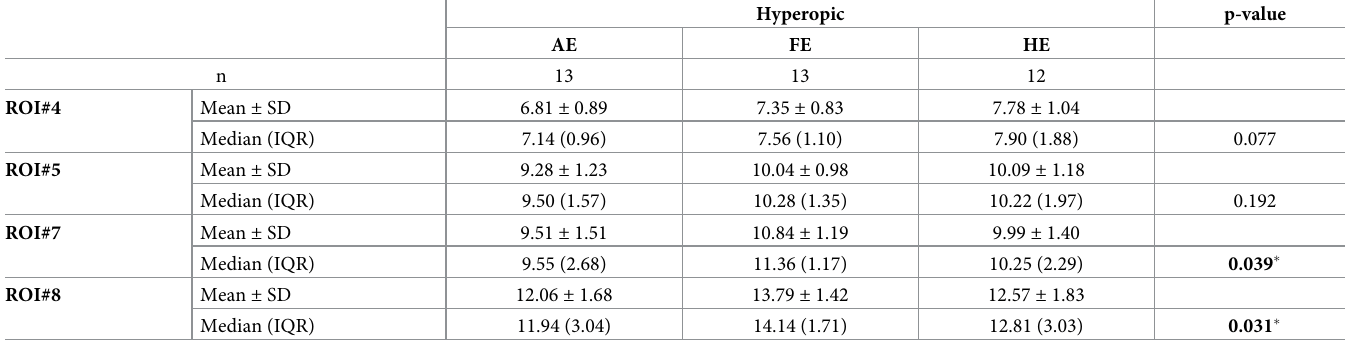
Table 5. Comparison of the reflectivity of the ROIs#4, 5, 7 and 8 among amblyopic, fellow, and healthy eyes in hyperopic